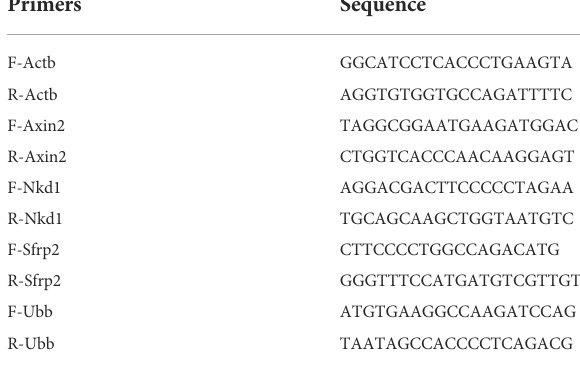
TABLE 1 List of primers for QPCR